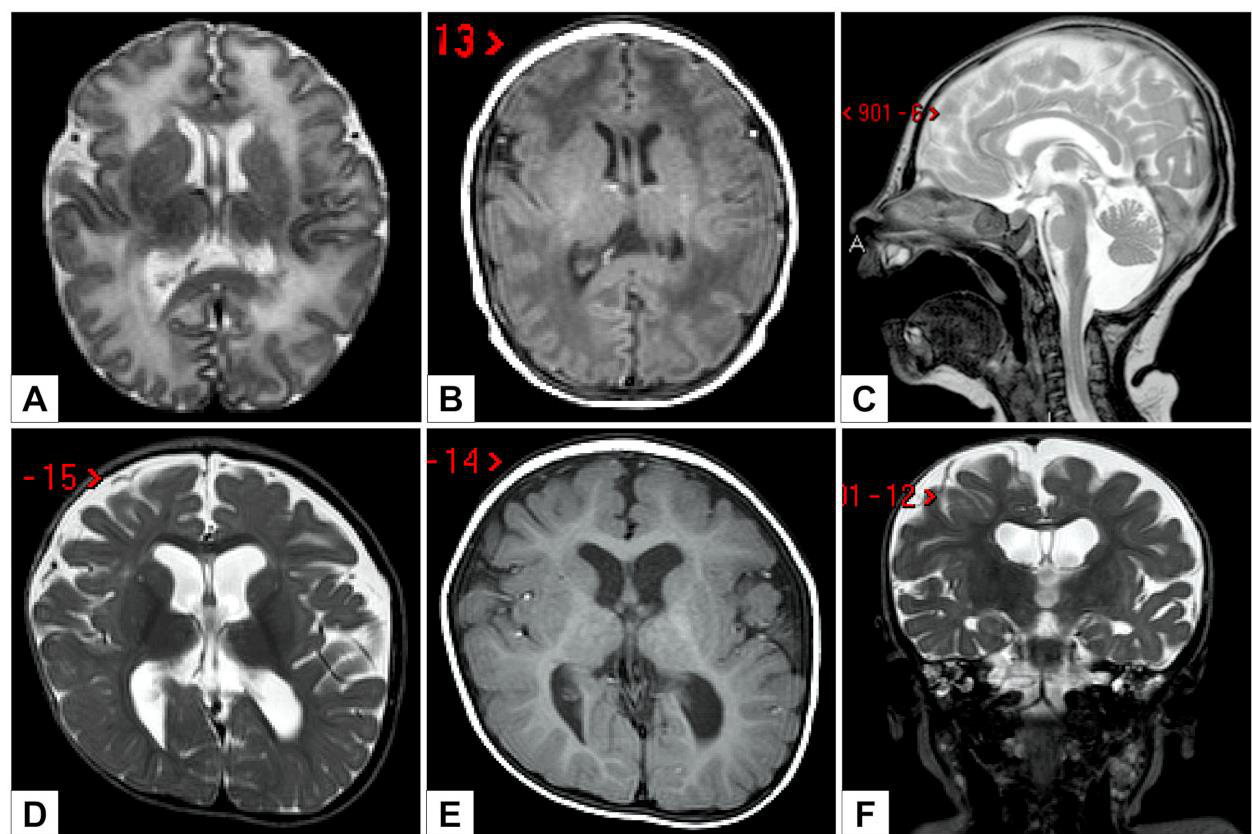
Figure 3. T2 axial ( A ), T1 axial ( B ), and T2 sagittal ( C ) images obtained at 5 days show global white matter signal anomalies ( A , B ). Midsagittal images show Blake pouch cyst with enlargement of the fourth ventricle, which communicates with an infravermian cystic compartment ( C ). T2 axial ( D ), T1 axial ( E ), and T2 coronal ( F ) follow-up images at 11 months show global white matter reduction with development of significant atrophy with lateral ventricles and subarachnoid spaces enlargement ( D , E ) and bilateral hippocampal malrotation ( F ).